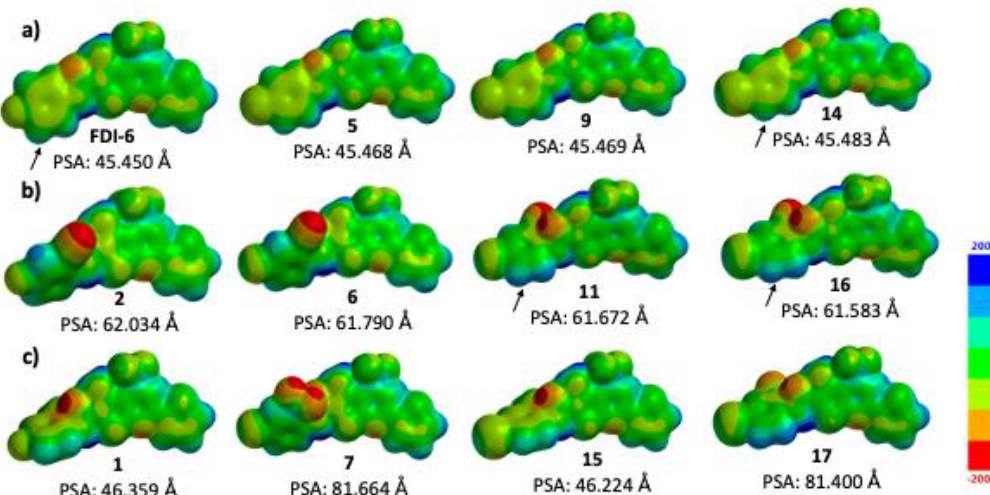
Figure 8. Polar surface area and MEP maps superimposed onto the total electron density at a value of 0.002 e − /au 3 , for ( a ) FDI-6 , 5 , 9 , and 14 ; ( b ) 2 , 6 , 11 , and 16 ; and ( c ) 1 , 7 , 15 , and 17 . Blue, red, and green colors show positive, negative, and neutral MEP regions, respectively. The black arrows indicate those blue regions (MEP positive values) in the aromatic protons, adjacent to the amide proton.